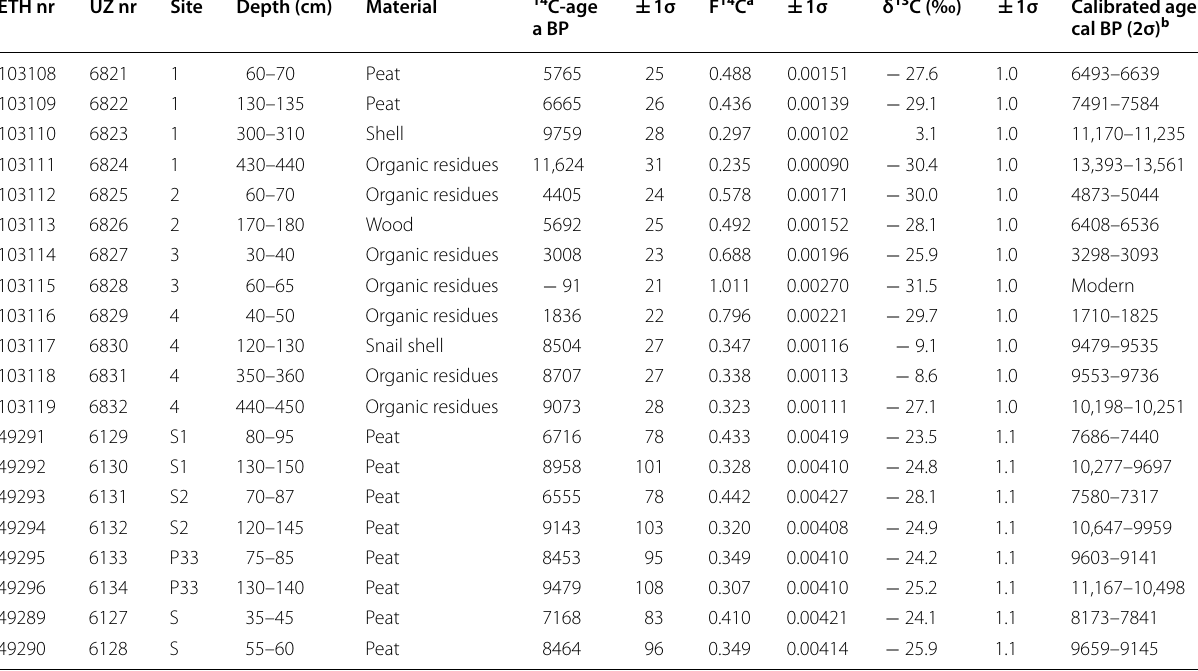
a Fraction modern carbon b OxCal4.3, IntCal13 (Reimer et al.